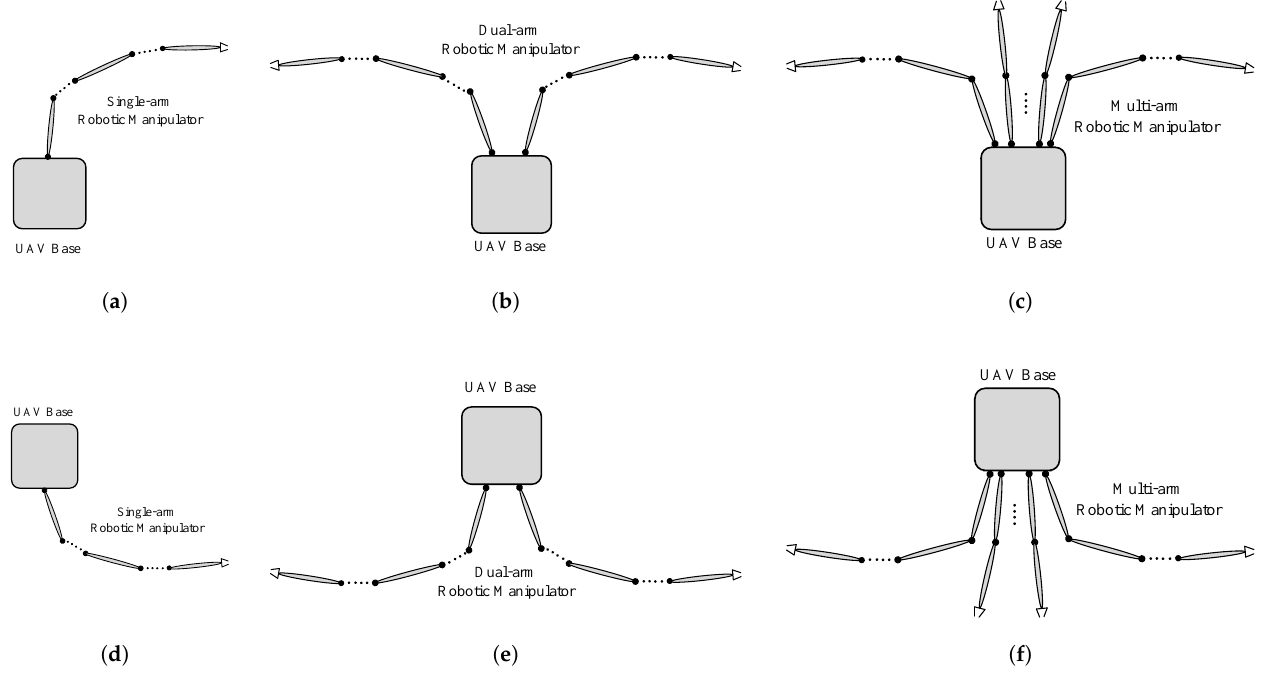
Figure 1. Two-dimensional (2-D) sketch of aerial robotic manipulator composed of a UAV base and a robotic manipulator, where the manipulator denotes ( a , d ) one single arm, ( b , e ) two arms or ( c , f ) multiple